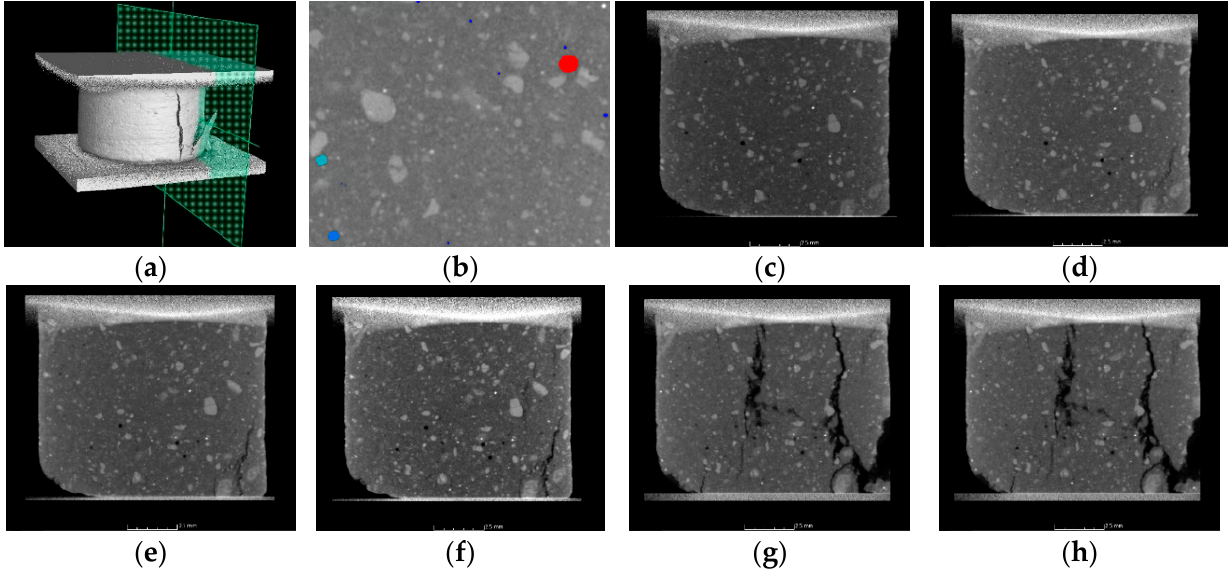
Figure 6. Destroyed cementitious soil during tomographic examination: ( a ) cross-sectional location on 3D reconstructed specimen; ( b ) graphical result of porosity analysis (zoom) color scale indicates pore size, ( c ) sample inside Deben, unloaded condition, ( d ) sample inside Deben, piston displacement 0.12 mm, ( e ) sample inside Deben, piston displacement 0.18 mm, ( f ) sample inside Deben, piston displacement 0.24 mm, ( g ) sample inside Deben, piston displacement 0.48 mm, ( h ) sample inside Deben, piston displacement 0.54 mm. Source: own materials.